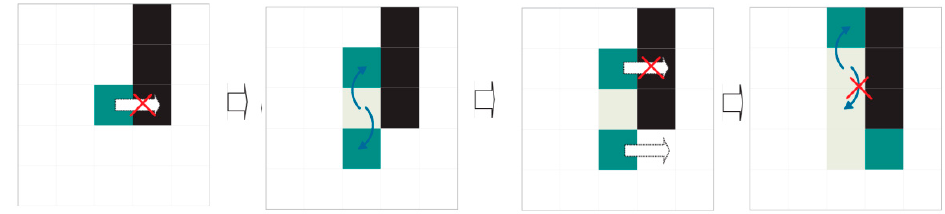
Figure 14. MITOSIS: Oblique locations are explored. Both are legal, and offspring are generated. The descendants inherit the position history of the progenitor and continue their progress. The progenitor simply disappears. Figure 15. MITOSIS: The locations to the north and south are explored as a second step, thus generating offspring. In this case the southern agent advances but not the northern agent, which must perform a new mitosis.